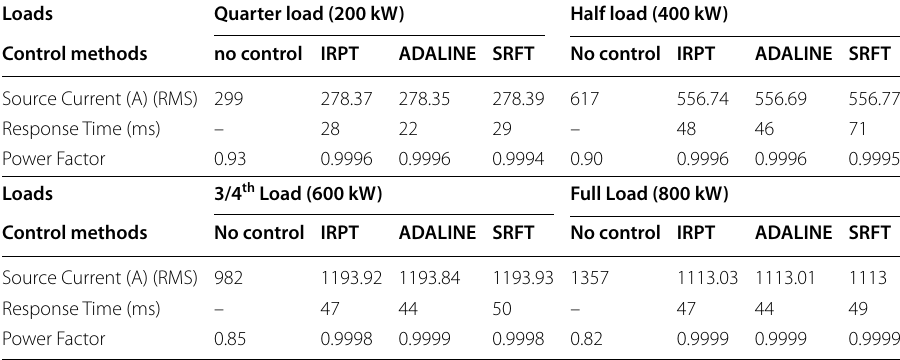
Table 3 Power factor and correction time of different load conditions with different controllers Loads